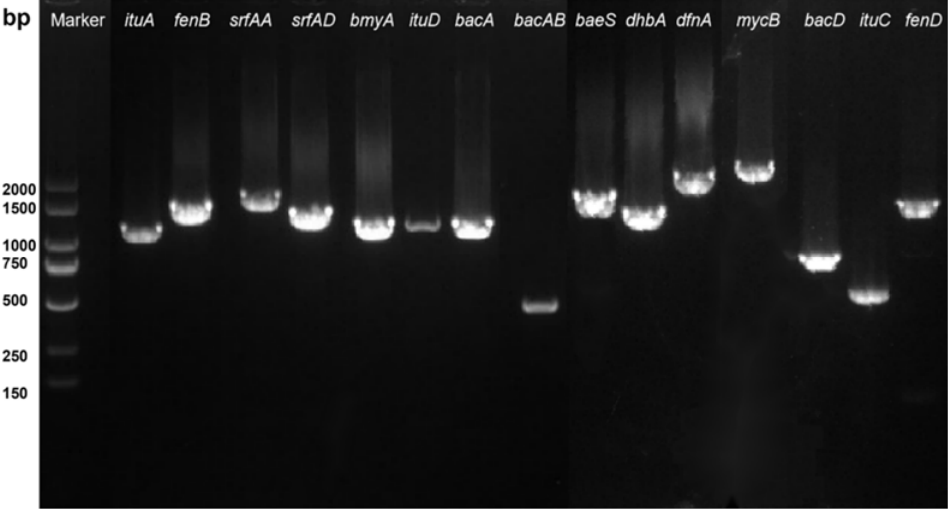
Figure 5. PCR detection of 15 biosynthetic genes ( ituA , fenB , srfAA , srfAD , ituD , bacA , bacAB , baeS , dhbA , mycB , bacD , ituC , and fenD ) of antifungal substances in Bacillus velezensis